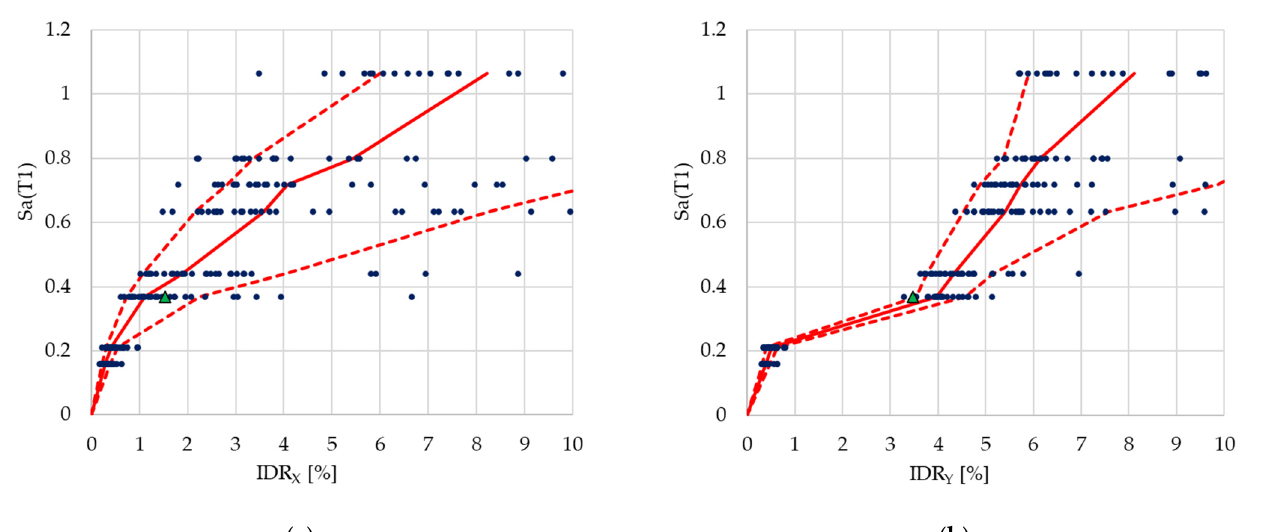
Figure 6. Peak interstorey drift ratio (IDR) vs Sa (T 1 ). ( a ) Case I with IDR measured in X direction; ( b ) Case II with IDR measured in Y direction. The green triangles indicate the results of the first time-history of Table 1.